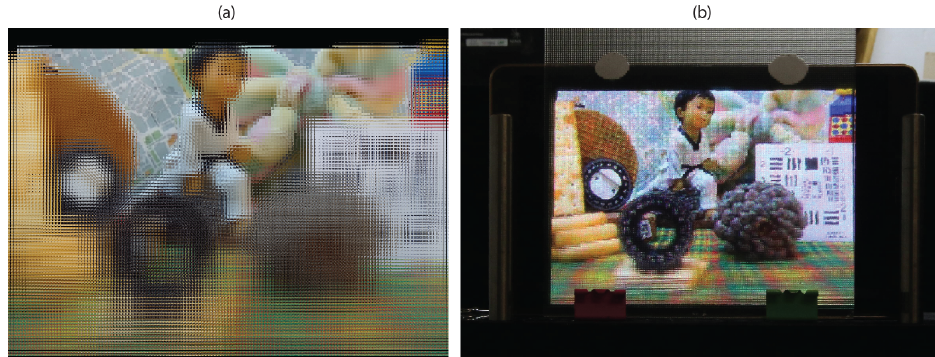
Figure 10. Pitch selection: ( a ) The integral image obtained with the same reference plane and field of view of Figure 7d, with five times its pitch. The DOF is greatly reduced with respect to the image of Figure 7d. ( b ) Projection in 3D InI display. The objects appear increasingly defocused as we move far from the reference